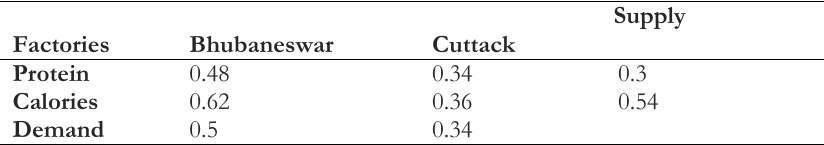
Table 13. Final initial basic feasible solution.